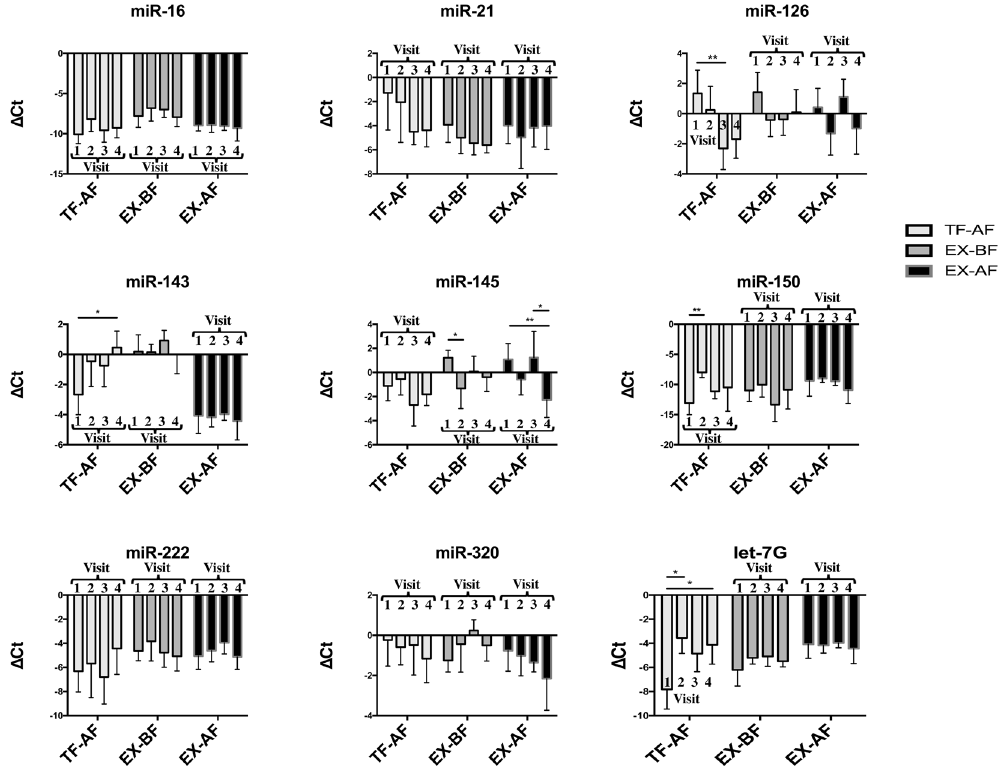
Figure 3. Evaluation of Δ Ct (the miRNA Ct value minus the normalizer Ct value, let-7a, of the corresponding time) values over 4 consecutive weeks (V1; V2; V3; and V4) of the miRNA set from exosomes isolated by the three confident methods (TF-AF; EX-BF; and EX-AF). All the data are presented as the mean values (n = 7) (error bars correspond to the standard deviation). * p < 0.05; ** p <